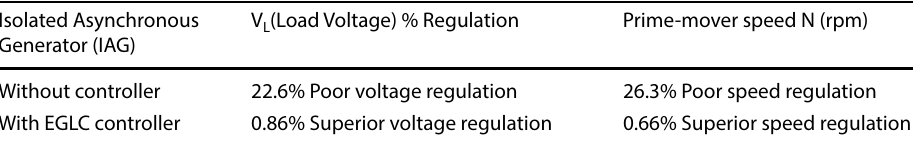
Table 2 Comparison of outcomes with and without EGLC